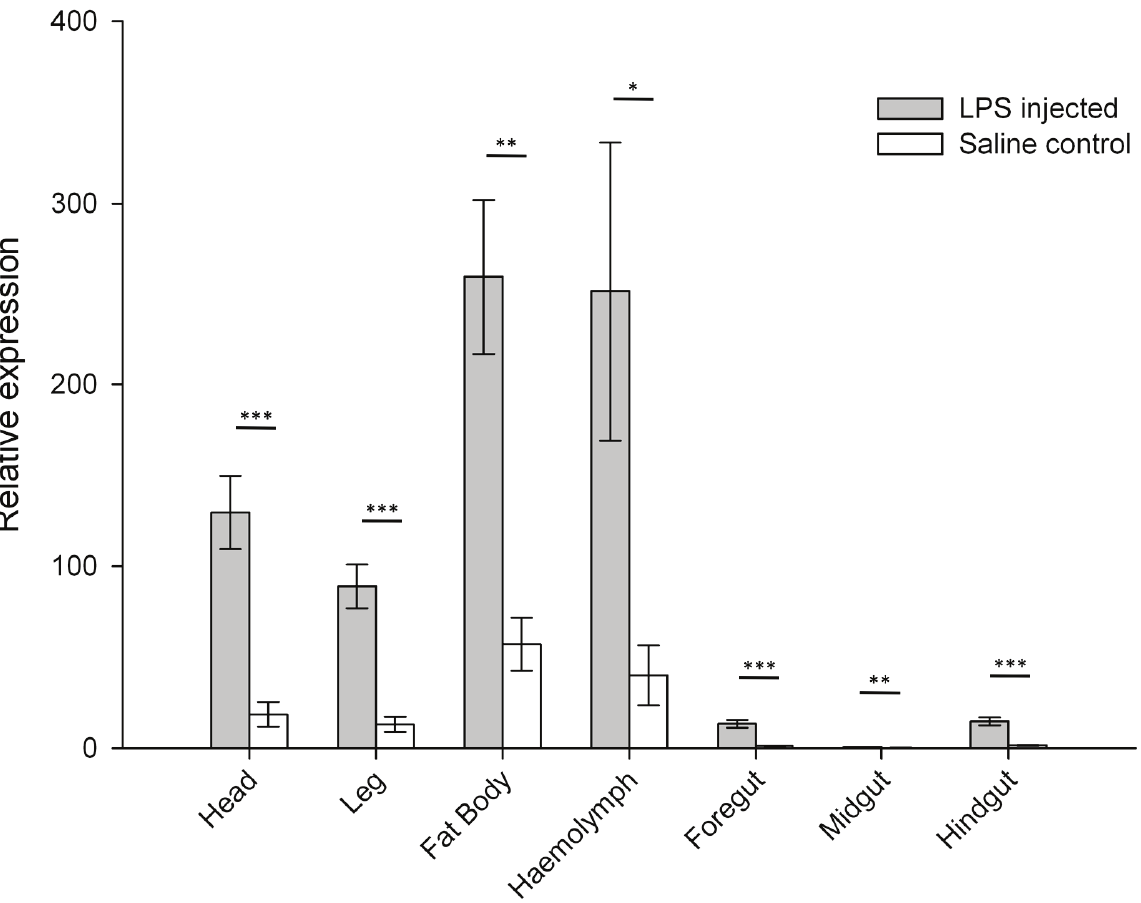
Figure 1. Relative expression levels of saline control and LPS-injected Locusta migratoria for the immune gene encoding peptidoglycan recognition protein SA (PGRP-SA) in